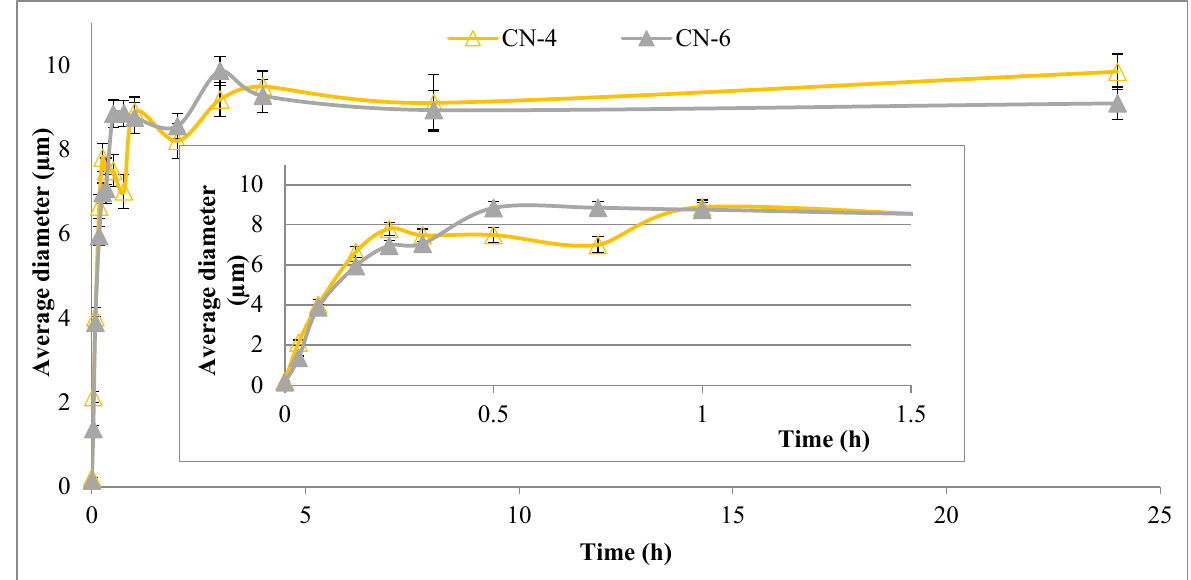
Figure 8. The influence of the aqueous environment on the size of CN-4 and CN-6 samples over time. After 24 h the diameter of the NCs had values between 5700 and 10,300 nm. Being